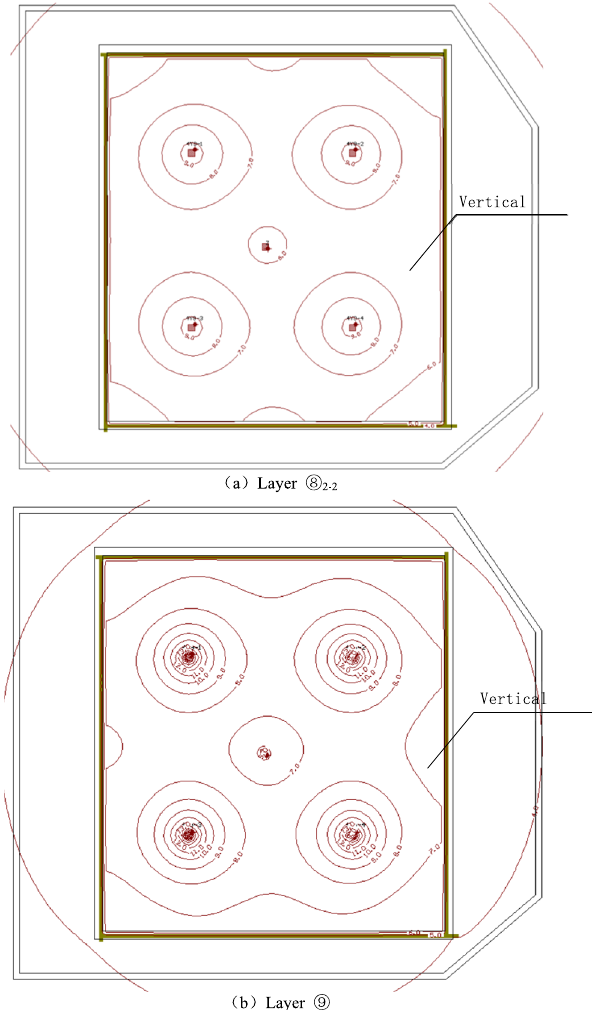
Figure 4. Contour map of the aquifer